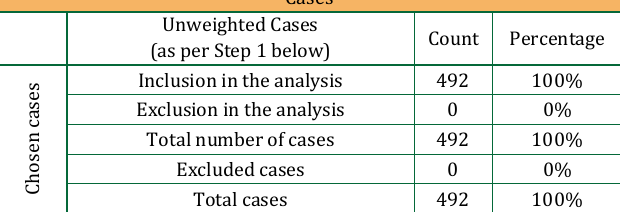
Figure 1: The decision tree diagram for death and survival prediction Table 3: Details of Case Processing Based on Included and Excluded Cases